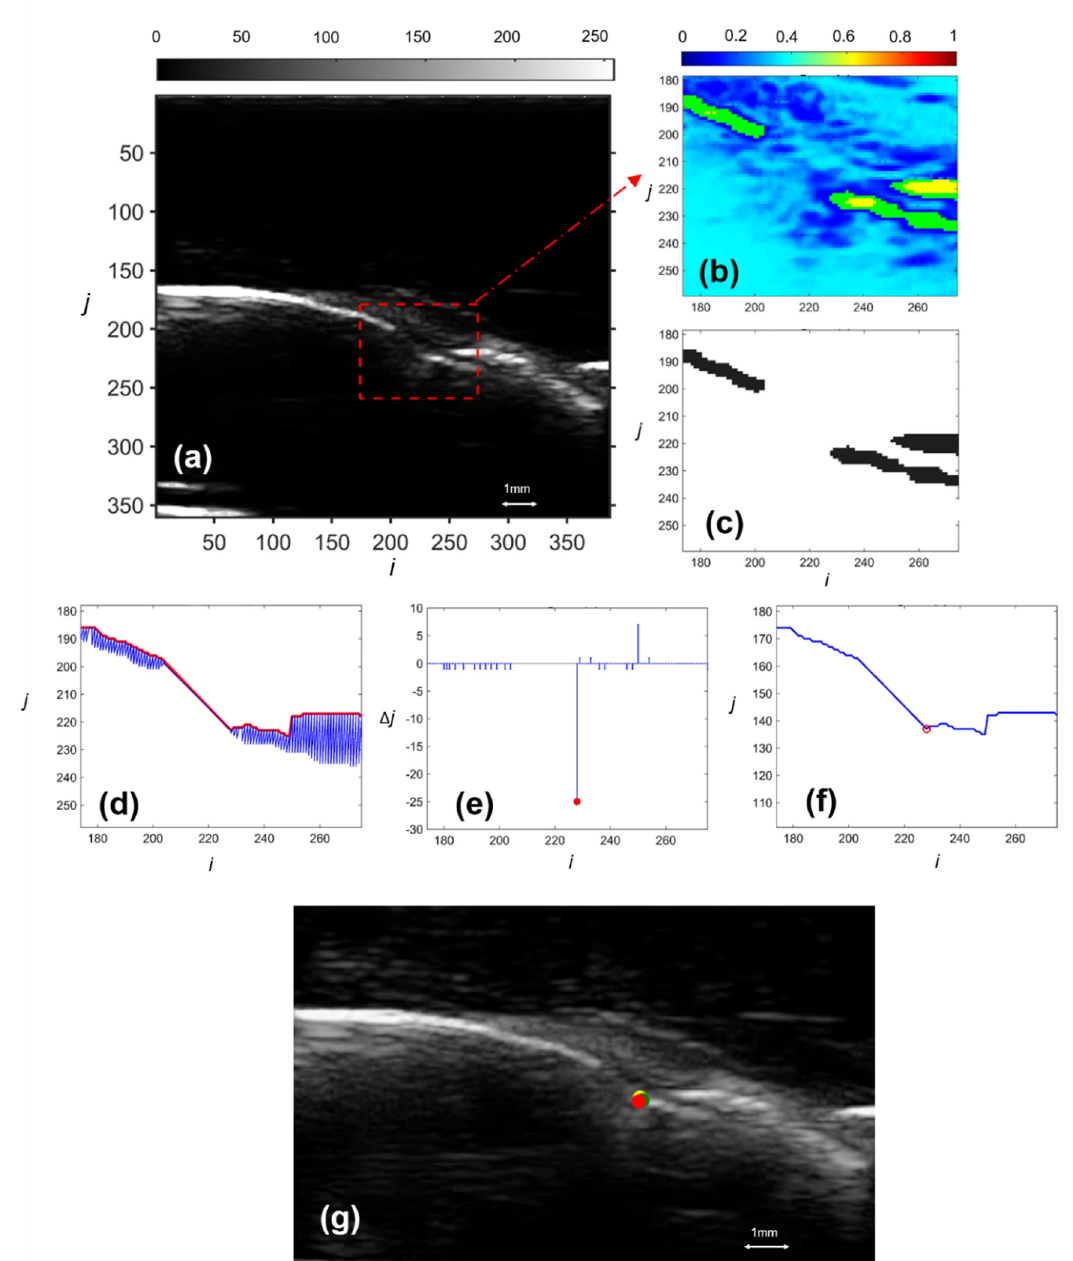
Figure 5. An example of the computer-assisted CEJ detection on an ultrasound image. ( a ) A bounding box containing the CEJ; ( b ) the corresponding color image of the ROI; ( c ) region extraction using K -mean clustering; ( d ) edge detection; ( e ) local difference calculation; ( f ) CEJ identification at maximum difference; ( g ) comparison of the CEJ location by the proposed method (red dot) and manual CEJ identification by raters 1 and 2 (green and yellow dots).